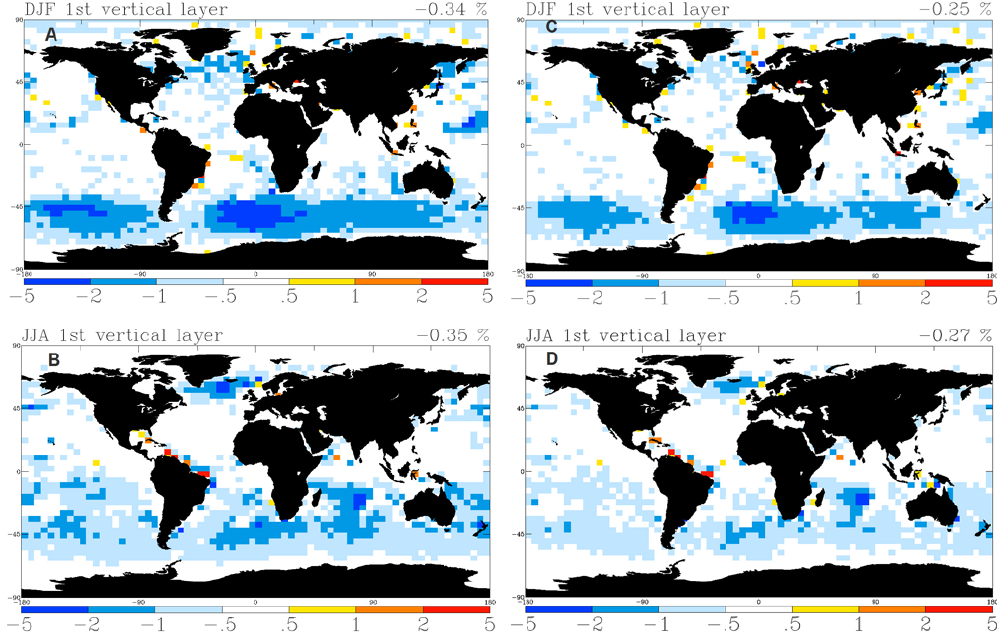
Fig. 3. Relative change (in percent) in CCN(0.2%) concentrations ignoring surfactant effects (panels A and B ) and with surfactant effects (panels C and D ) of marine organic aerosols for a three-month seasonal average over December, January, and February (panels A and C ), and June, July, and August (panels B and D